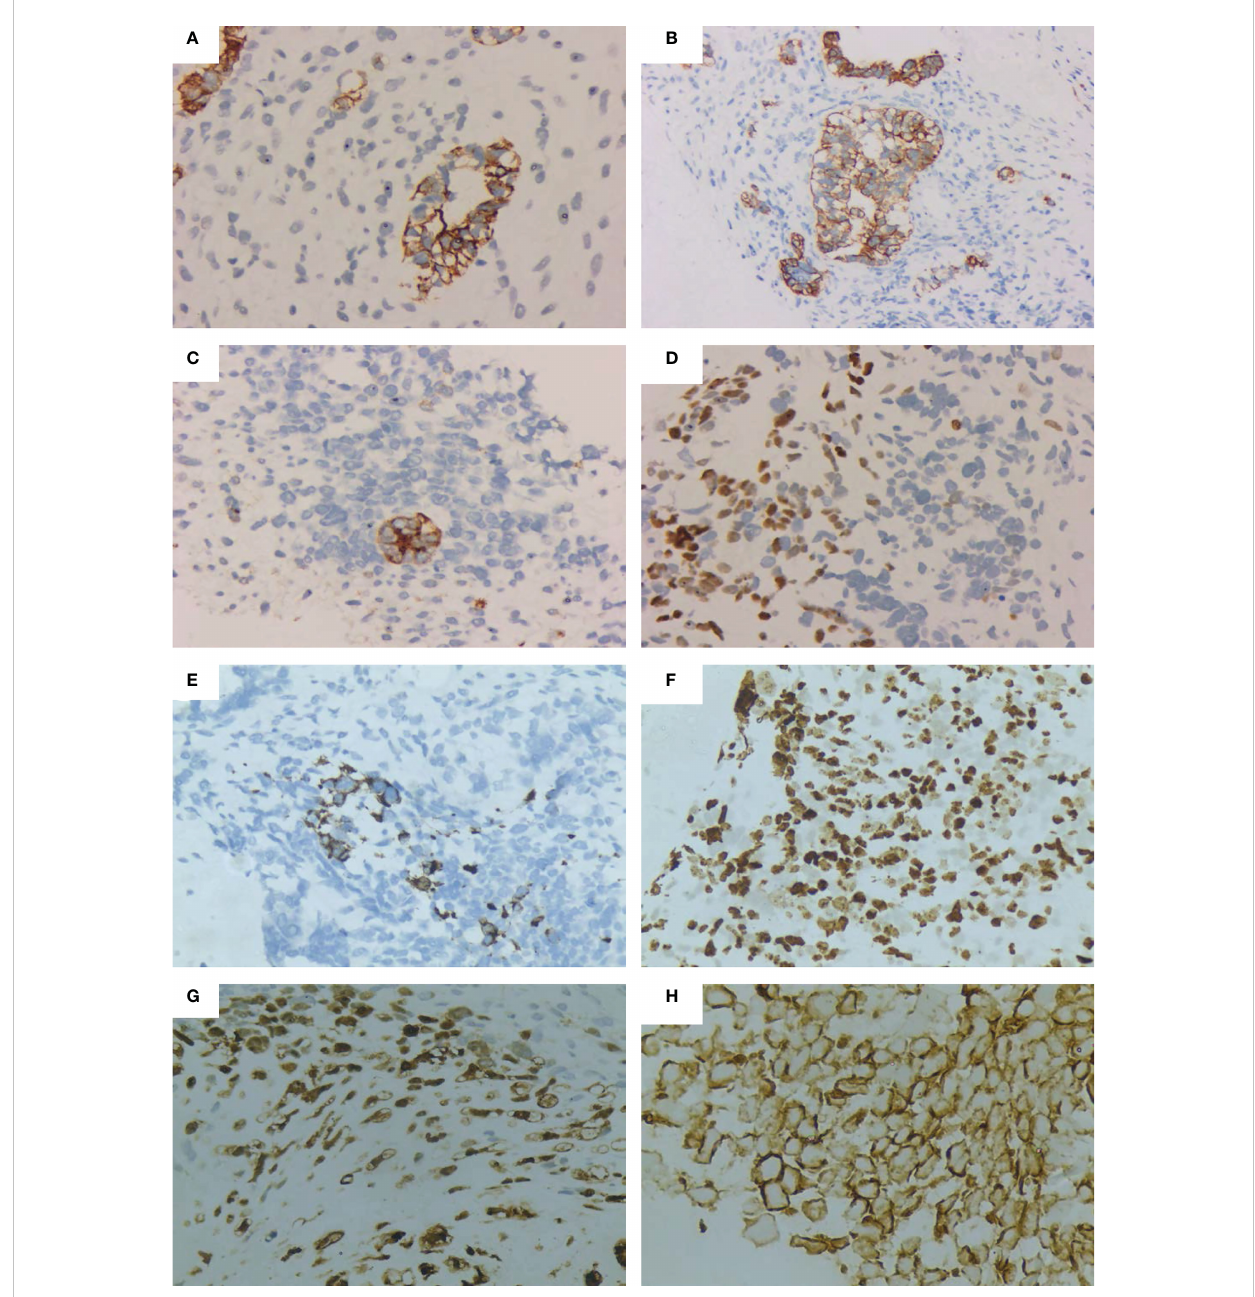
FIGURE 2 Immunohistochemical images of the pulmonary blastoma patient. (A) CK positive(Microscopic magni fi cation×100). (B) CK positive (Microscopic magni fi cation×200). (C) EMA positive (Microscopic magni fi cation×200). (D) TTF-1 positive (Microscopic magni fi cation×200). (E) Desmin positive (Microscopic magni fi cation×200). (F) Ki-67 positive (Microscopic magni fi cation×200). (G) S-100 positive (Microscopic magni fi cation×200). (H) Vimentin positive (Microscopic magni fi